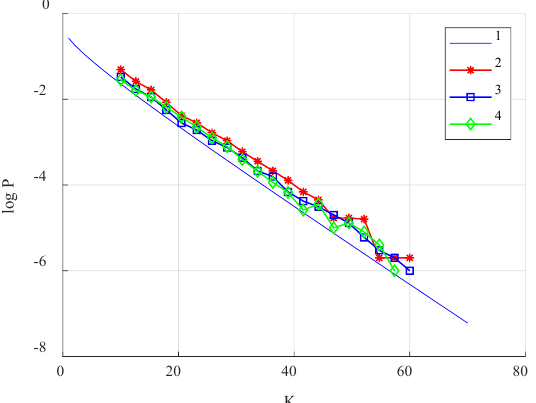
Figure 6. Bit error probability as a function of the processing gain in the absence of interference; line 1 corresponds to analytical estimate; curve 2 corresponds to simulation with Gaussian distribution, 3—uniform distribution; 4—telegraph distribution.